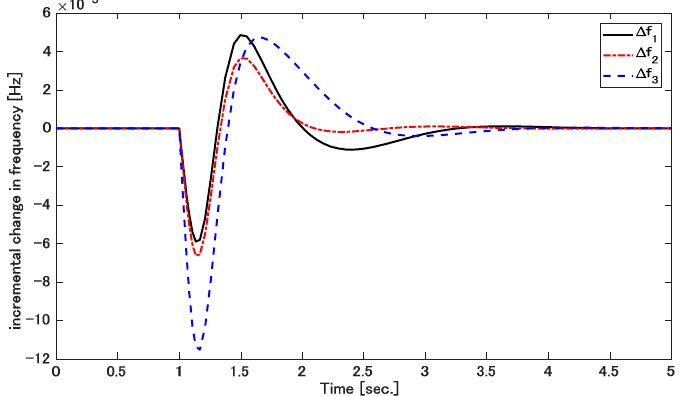
Figure 4. Frequency deviation of three-area power system.